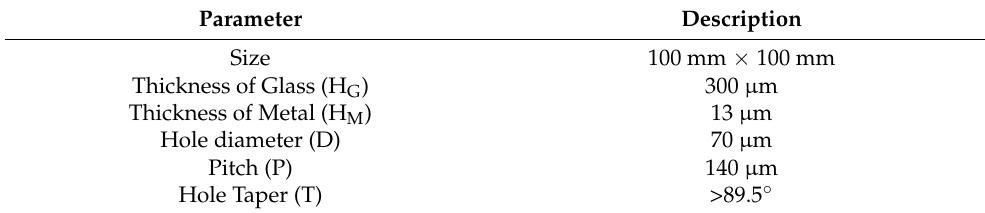
Table 1. Parameter setting of GEM.